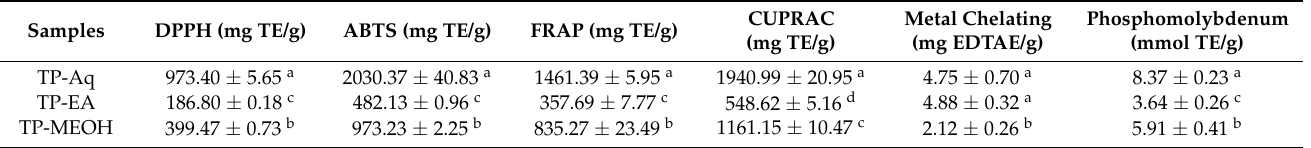
Table 4. Antioxidant potential of the assayed extracts.